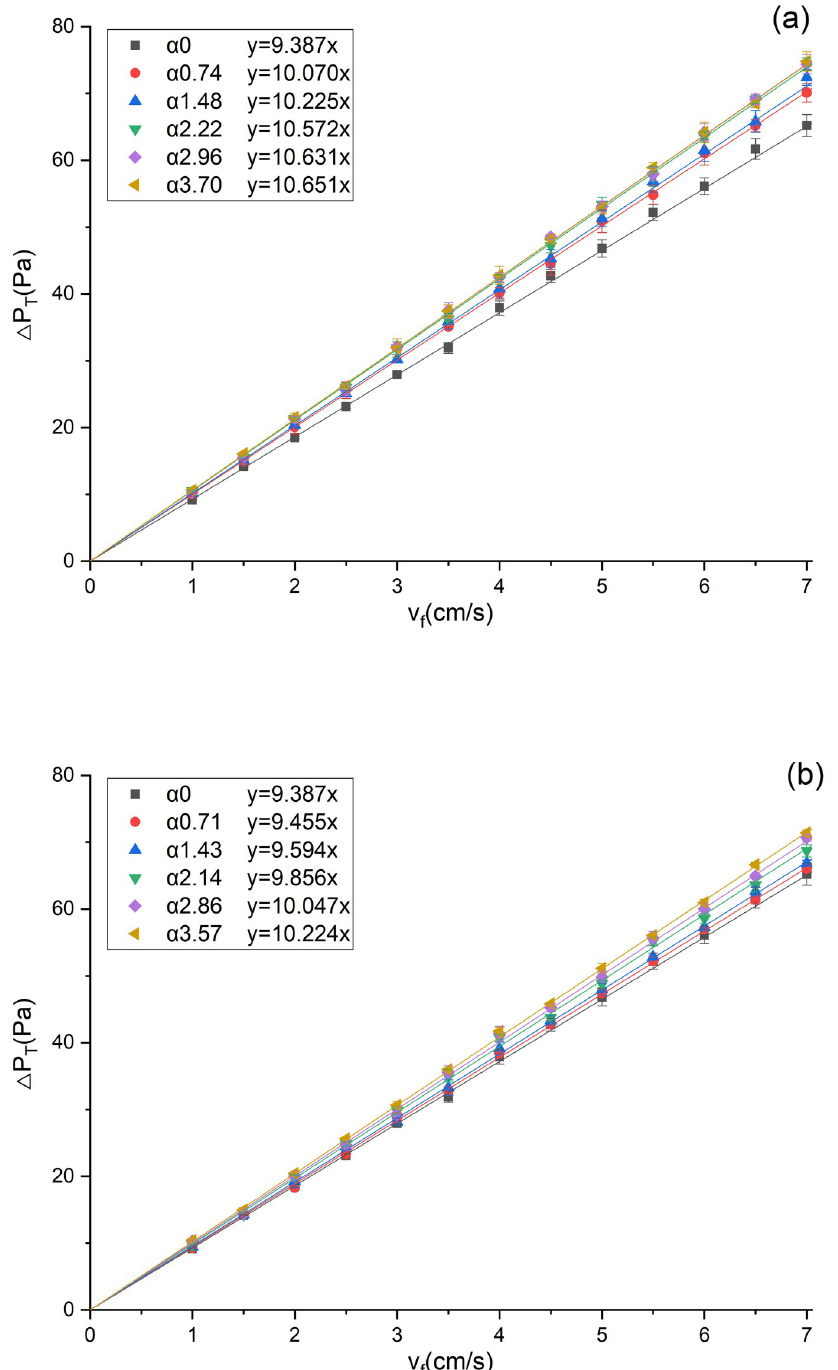
Fig 7. Variations of the total pressure drop with filtration velocity (a)V-shaped, (b) U-shaped.